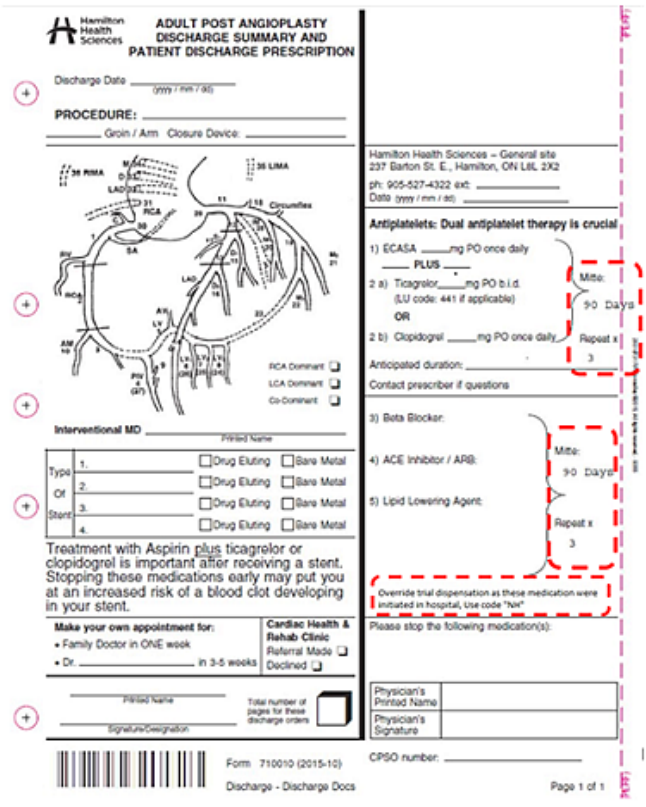
Figure 3. Example discharge prescription from Hamilton Health Sciences with intervention revisions